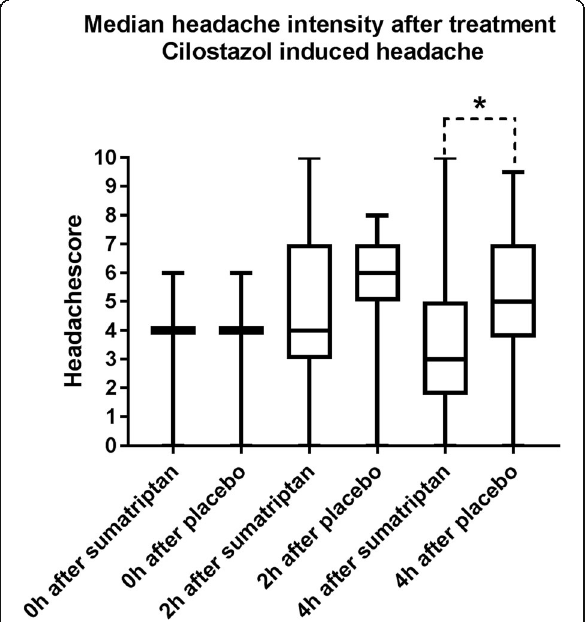
Fig. 3 Median headache intensity after treatment of cilostazol induced headache. Median headache score at different time points after treatment of cilostazol induced headache. Difference in median headache intensity at 2 h: p = 0.09. Difference in median headache intensity at 4 h: p =